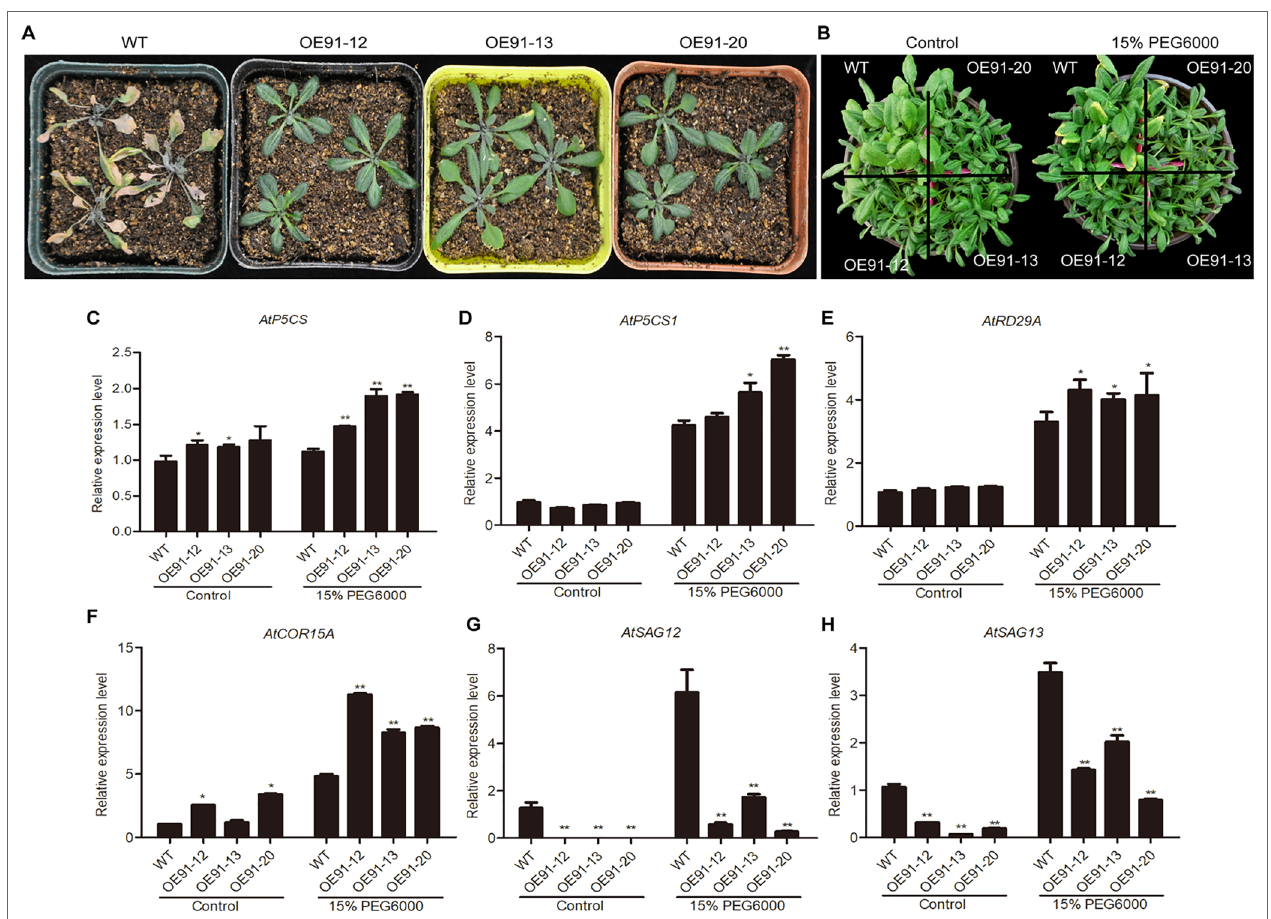
FIGURe 6 | Overexpression of GhWRKY91 in Arabidopsis plants improved drought tolerance. (a) Phenotypic characteristics of six-week-old WT and transgenic plants under water deficit conditions. Four-week-old WT and transgenic plants grown in soil were subjected to a water shortage treatment for approximately two weeks. (B) Phenotypic characteristics of four-week-old WT and transgenic plants under the control and PEG6000 treatments. Three-week-old WT and transgenic plants grown in soil were irrigated with 15% PEG6000 for one week. Plants grown under normal growth conditions severed as controls. All the plants were grown in a greenhouse at 22 ± 1°C under a 16 h light/8 h dark approximately. (C – F) Expression levels of the stress-related genes AtP5CS , AtP5CS1 , AtRD29A, and AtCOR15A in four-week-old WT and transgenic plants. (G – h) Expression levels of the SAGs AtSAG12 and AtSAG13 in the WT and transgenic plants. AtUBQ10 was used as the reference control. The data are the means ± SEs of three biological replicates. ** P < 0.01 and * P <